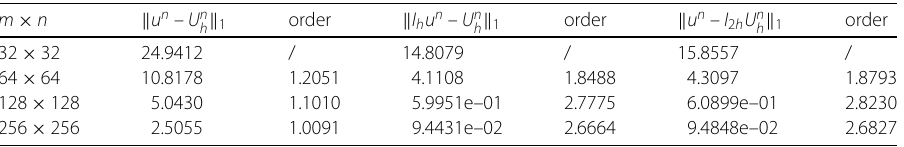
Table 11 Numerical results of u at t = 3 m ×